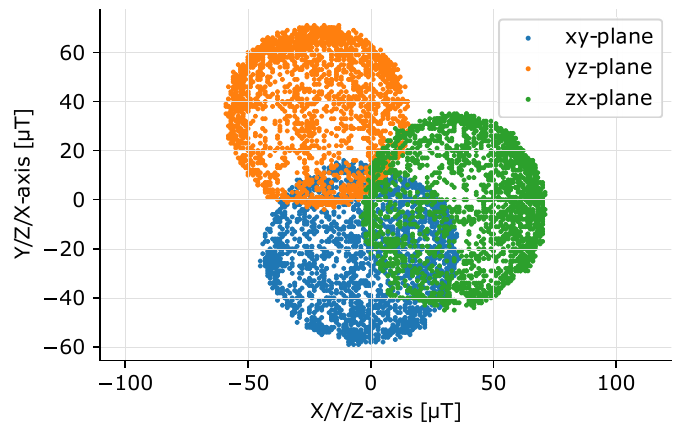
Figure 4. 2D plot of a sphere after rotating the sensor node around each axis before calibration. The circles are not perfectly round (elliptical sphere in 3D) caused by soft iron distortions. Also, offsets between the centers of the circles and the origin, caused by hard iron distortions, are present.